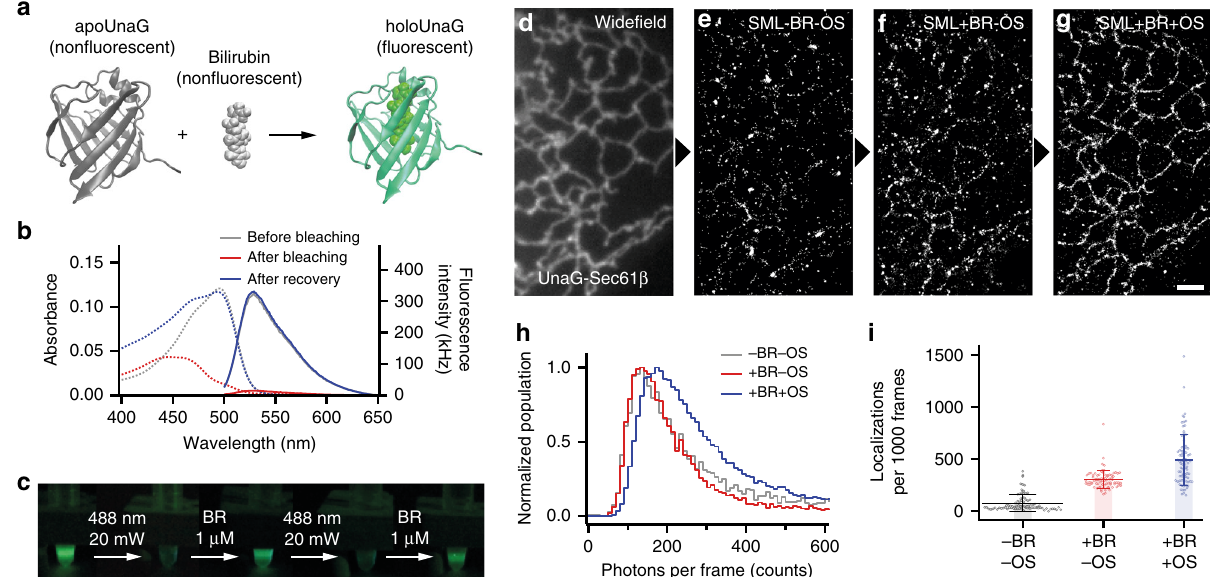
Fig. 1 Repetitive on- and off-switching of holoUnaG by external bilirubin (BR) and light exposure. a Scheme of BR-inducible fl uorescence of UnaG. Crystal structures of apoUnaG, BR and holoUnaG are obtained from Protein Data Bank (PDB, ID: 4I3B). b Absorption (dashed lines) and fl uorescence emission (solid lines) spectra of holoUnaG before bleaching (gray), after bleaching (red) and after recovery (blue). Abnormally large absorbance at < 460 nm in the blue dashed line may come from the additional BR at 1 µ M for the recovery. c Repetitive photobleaching and fl uorescence recovery of holoUnaG. Each picture was captured with 200 µ W of 488-nm excitation light after indicated treatments for 60 min each. d – g Wide fi eld image and series of localization dataset of UnaG-Sec61 β transiently expressed in a fi xed Cos7 cell in different imaging buffer compositions. Raw data for single-molecule localization were recorded with 10 ms camera exposure time for 30,000 frames. The same fi eld of view was observed sequentially from the left ( d ) to the right ( g ) under identical optical conditions for the localization datasets. h Normalized photon counts distribution and i the average number of localized molecules from the localization datasets in d – g . The photon counts distributions were normalized by their own maximum counts. Scale bar: 2 µ m. Error bars: standard deviations ( n = 80). BR bilirubin, OS oxygen